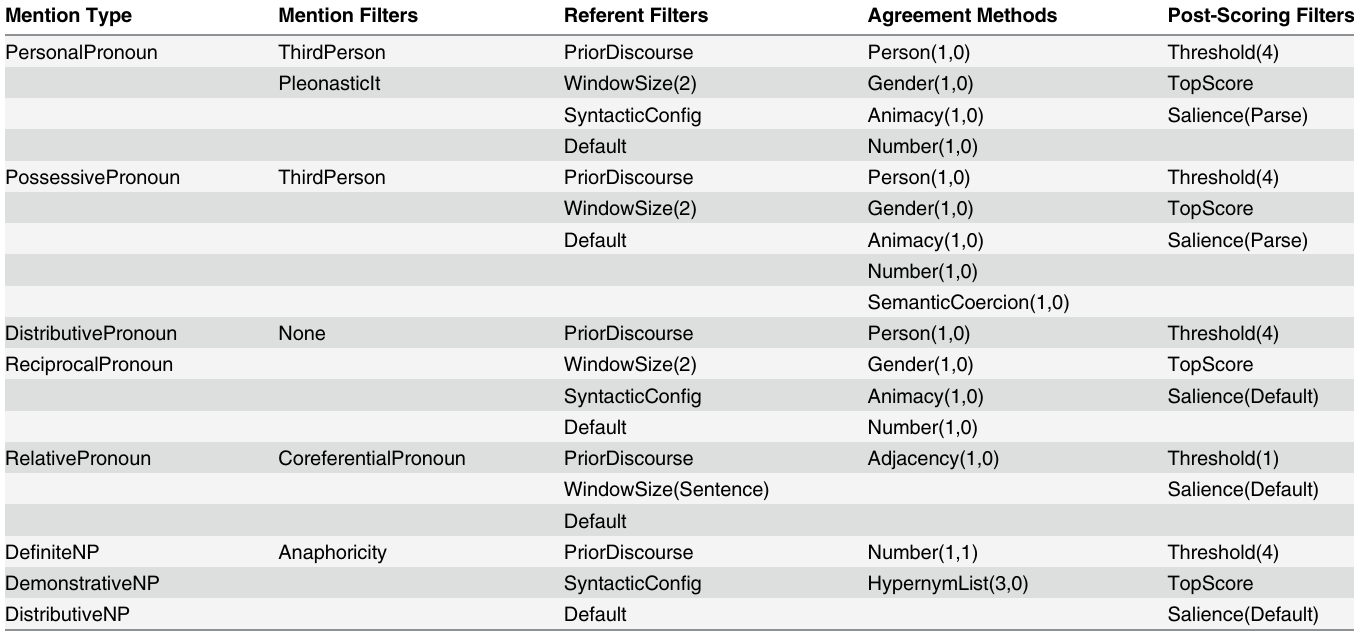
Table 14. Configuration for the Protein Coreference